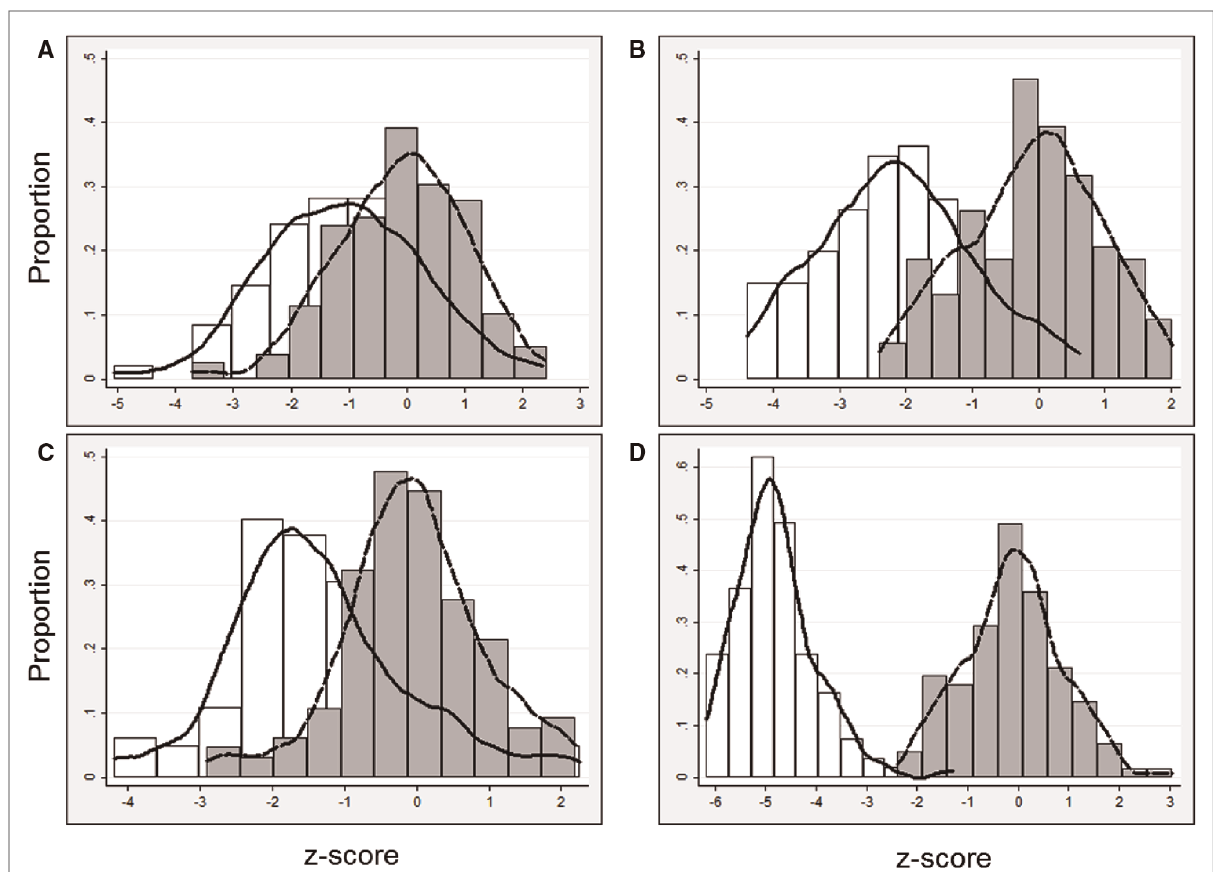
FIGURE 3 Left heart parameters (data derived from survivors only): distribution of z-scores and kernel density estimates from all fetuses with left CDH derived from (1) published data from unaffected fetuses (29) (white bars, solid line) and (2) left CDH-speci fi c data (gray bars, dashed line). CDH-speci fi c equations were derived with data only from survivors, ( A ) mitral valve diameter, n =92; ( B ) aortic valve diameter, n =87; ( C ) left ventricle length, n =90; ( D ) left ventricle width, n